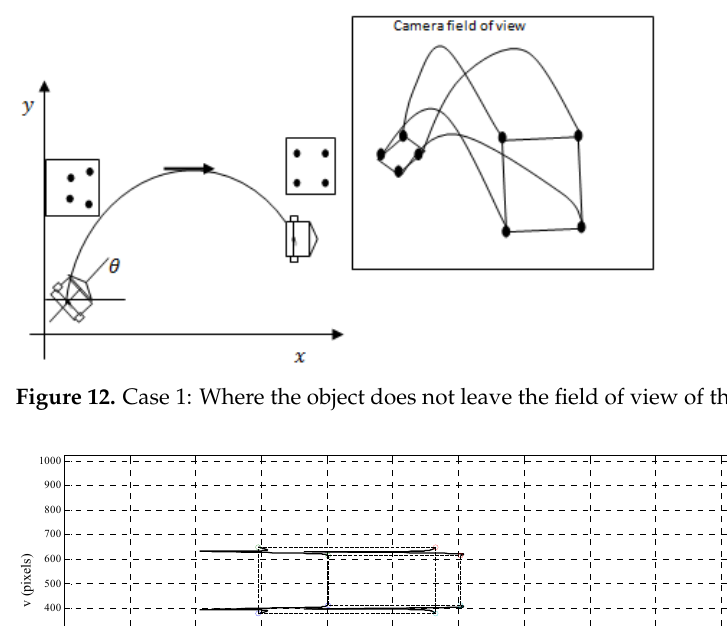
Figure 14. Case 1: Evolution of the trajectory of the robot in the Cartesian coordinate system. Figure 15. Case 1: Evolution of the control law u 1 . Figure 16. Case 1: Evolution of the control law u 2 .